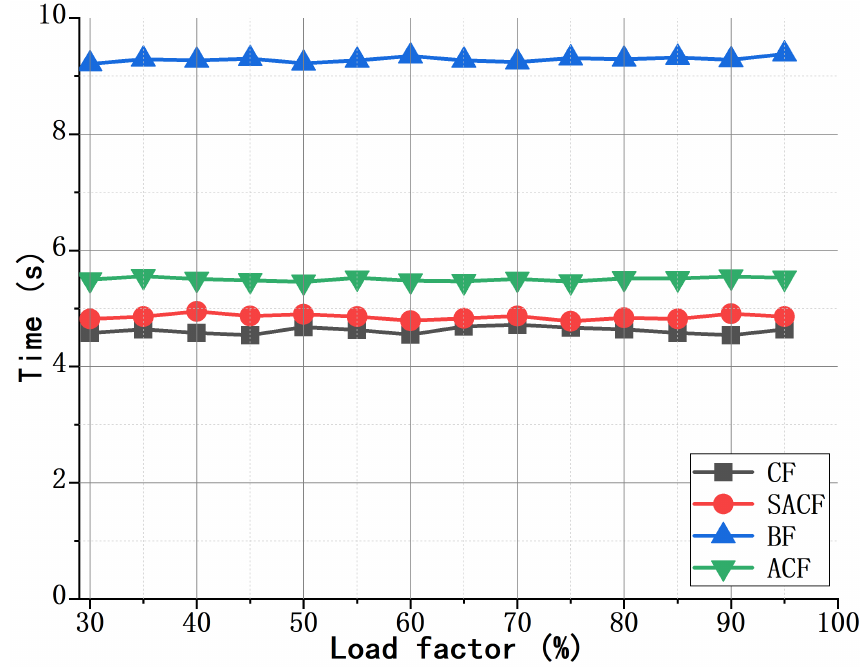
Figure 7. Times of 100 million positive queries at different load